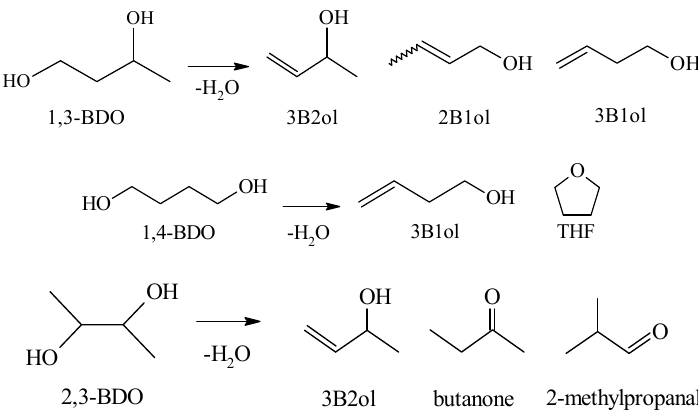
Figure 1. Dehydration of butanediols.